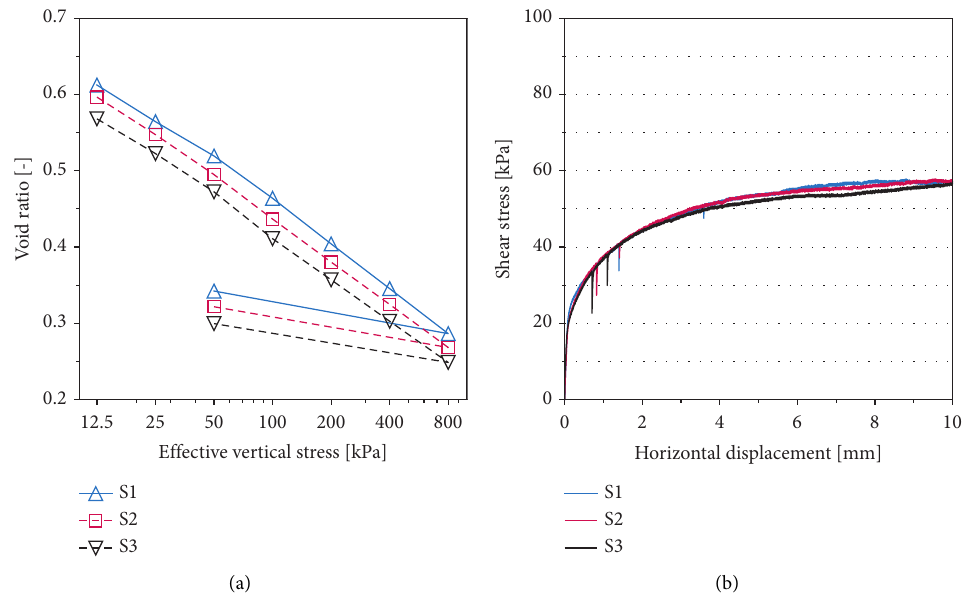
Figure 10: Mechanical behavior of the three sample preparations S1, S2, and S3 in (a) oedometer test and (b) direct shear